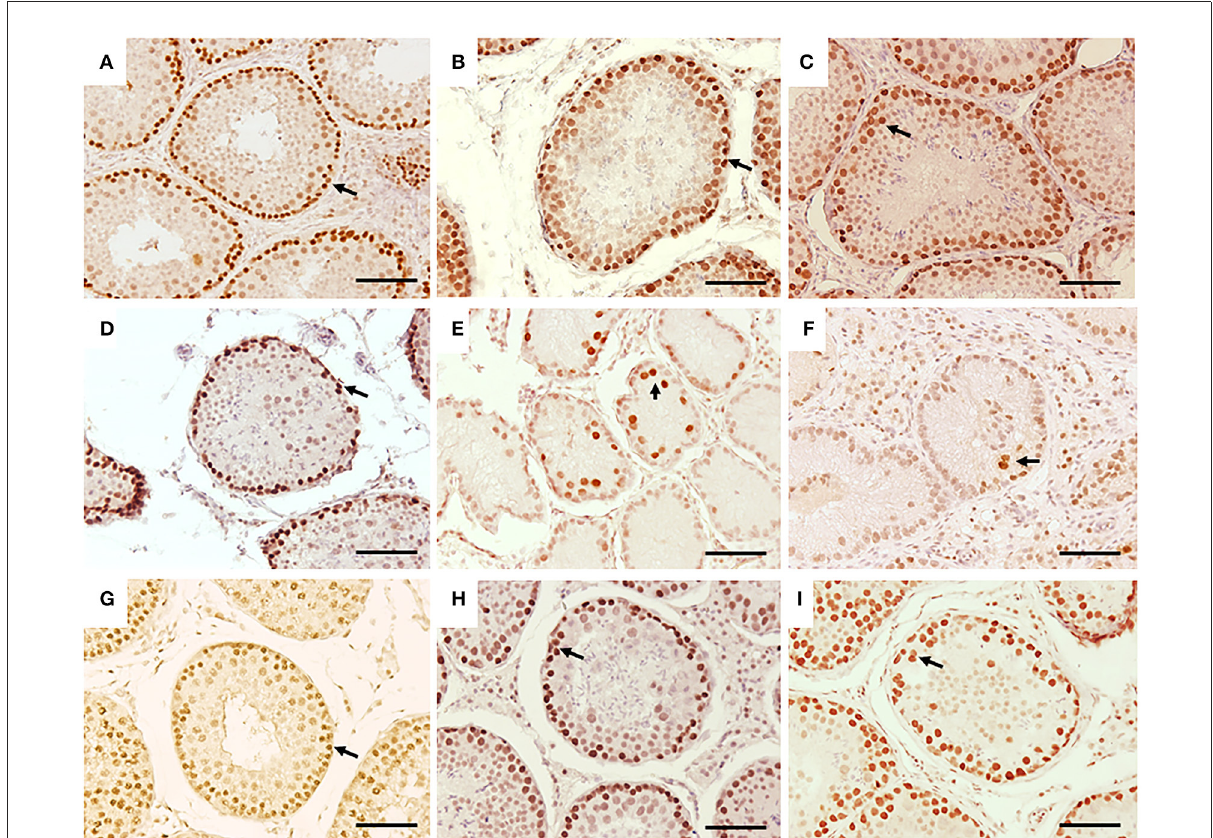
FIGURE3 Immunohistochemistry for PCNA in seminiferous tubes of dogs from the control group (CTRL) (A–C) ; from cryptorchidism (CO) (D–F) and contralateral (CONTRA) (G–I) in the peripubertal stages (first column); young adult (second column) and senile (third column). A marked immunoreactivity (arrow) is observed in the testes of the CTRL animals unlike the CO, mainly in the young adult stages. The testes of the CONTRA group show an immunoreactivity that is neither as marked as in the CTRL nor as weak as in the CO. Bar scale: 50 µ m.